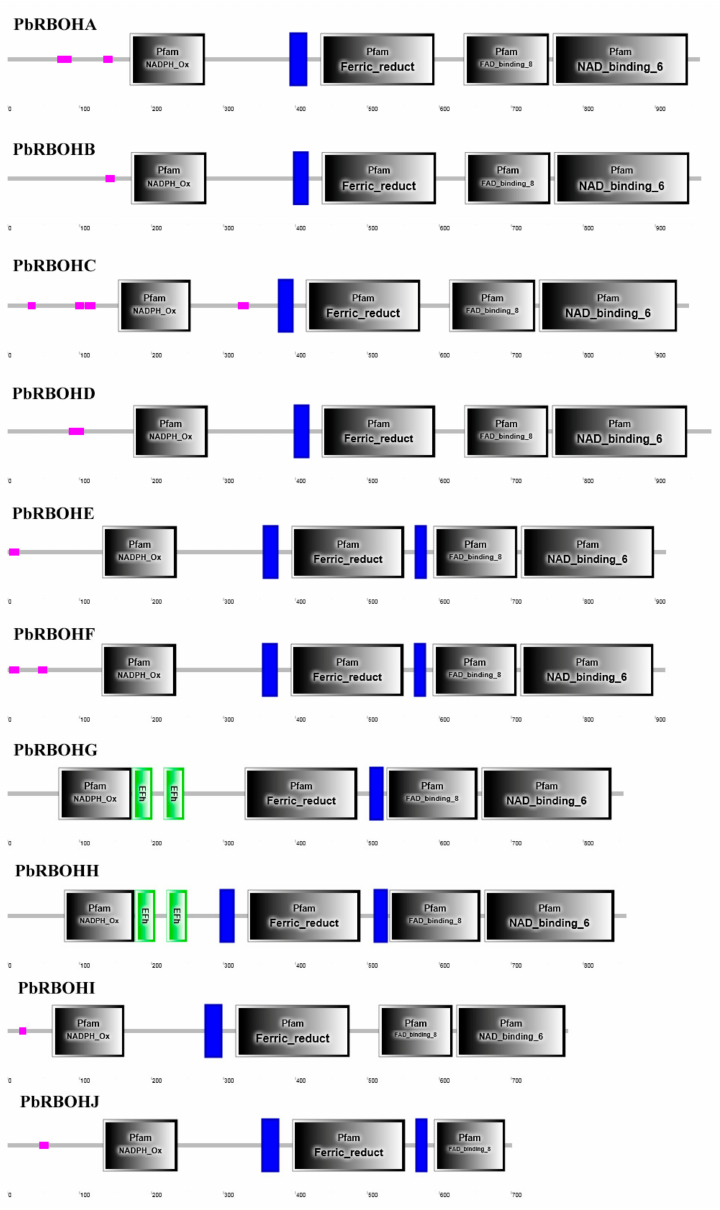
Figure 3. Depiction of various domains in PbRBOHs